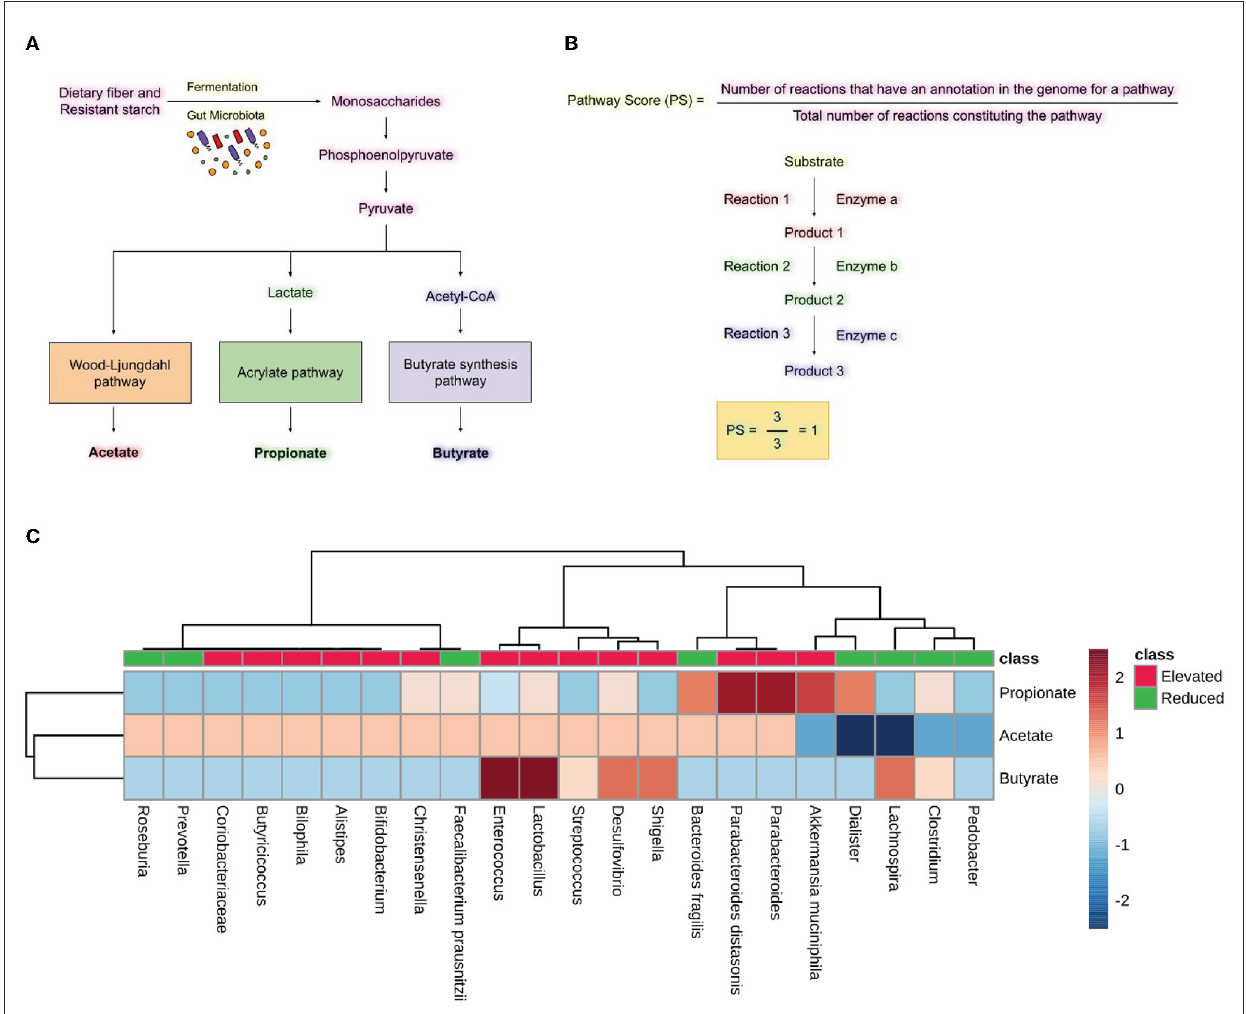
FIGURE5 Short-chain fatty acid synthesis pathway analysis. (A) Pathway for producing SCFA by gut microbiota by utilizing dietary fiber and resistant starch. (B) Formulas for calculating pathway scores (PS) of a metabolic pathway present in the microbes. (C) Heatmap showing pathway scores for producing SCFA like acetate, propionate, and butyrate in microbes found in elevated and reduced conditions in AD, PD, MS, and